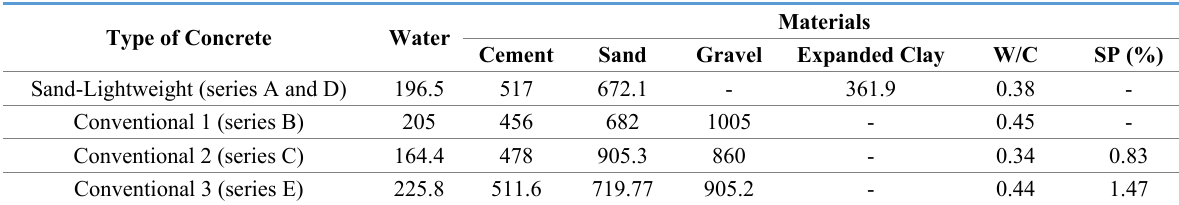
Table 1. Composition of concrete used in research (kg/m 3